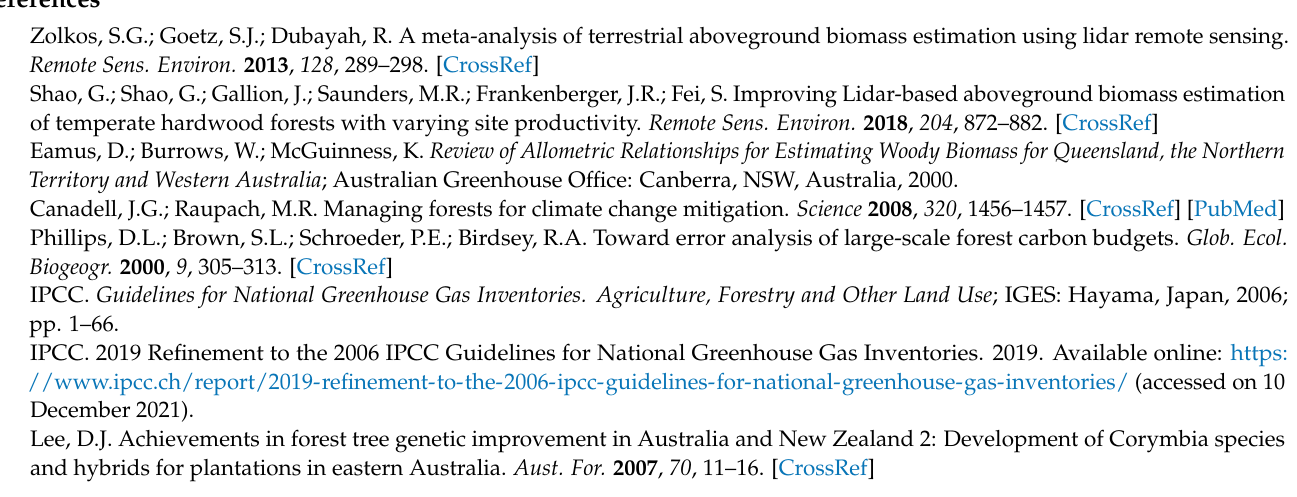
(right) of 52 sample trees used to develop biomass equations; Figure S2. (a) Plots of biomass estimation models based on data set 2a. With compound predictor variables of D, H, ρ and CD for 40 samples trees. See Table 4 for criteria associated with these regressions; (b) Plots of biomass estimation models based on data set 2b. With compound predictors variable of D, H, ρ and CV for 40 samples trees. See Table 4 for criteria associated with these regressions; Table S1. The Furnival’s Index (FI) used to compare logarithmically transformed models and weighted nonlinear models. The lower FI indicated more reliable models; Table S2. Average predicted error of biomass equations using Monte Carlo cross-validation (MCCV), the procedure was used 80% data used for training, 20% data for testing, the process is repeated 100 times for Equations (3)–(9) and 40 times for Equations (10)–(23); Table S3. Comparison of average errors of Equation (3) in this study and published AGB models for eucalypt